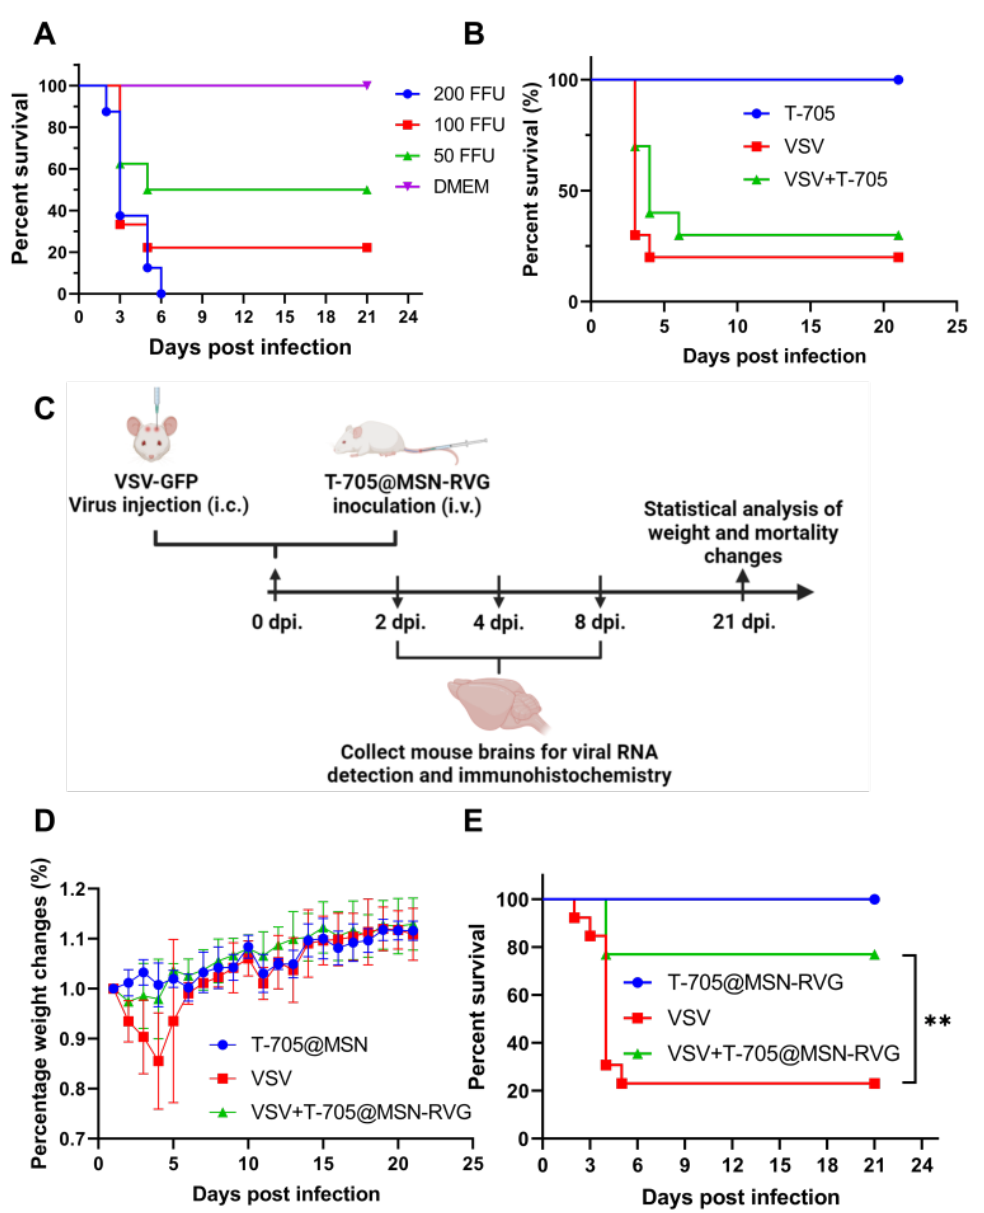
Figure 6. Antiviral treatment in mouse brains by T-705@MSN-RVG. ( A ) Six-week-old Balb/c mice were inoculated with VSV-GFP at 200 FFU, 100 FFU, 50 FFU, and DMEM by i.c. route ( n = 10). ( B ) Six-week-old Balb/c mice (VSV-GFP infected at 100 FFU) were inoculated with 25 µ L of T-705 (3 µ g/mL) via i.v. route ( n = 10). The mortality was recorded to analyze survival rates. ( C ) Schematic diagram of antiviral inhibition by using T-705@MSN-RVG. Six-week-old Balb/c mice (VSV-GFP infected at 100 FFU) were inoculated with 25 µ L of T-705@MSN-RVG (2 mg/mL) via i.v. injection ( n = 13). Bodyweight and mortality were recorded to investigate the ( D ) percentage weight changes and ( E ) survival rates. Statistical analysis of grouped comparisons was carried out by Log-rank (Mantel-Cox) test (** p < 0.01). The bar graph represents means ±